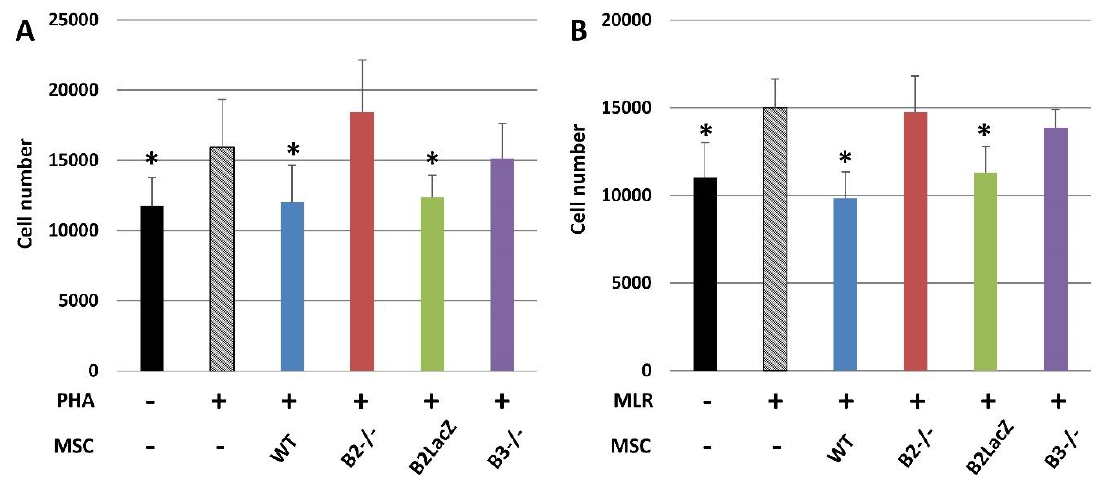
Figure 4. Immunomodulatory effects of MSCs on activated splenocytes. Immunomodulation mediated by either WT or Eph-B-deficient MSCs cocultured with activated splenocytes with either PHA ( A ) or MLR ( B ). In both experimental conditions, cocultures established with WT or Eph-B2-LacZ MSCs, but not those containing Eph-B2 −/− and Eph-B3 −/− MSCs, showed significant reduced splenocyte numbers as compared with activated splenocytes cultured alone (gray columns) (* p value < 0.05) ( n = 5).